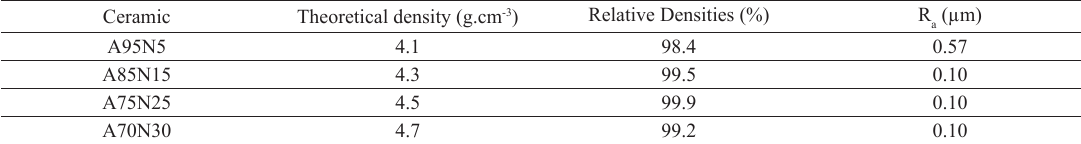
Figure 1. Optical micrographs of polished and etched composite surfaces: a) A95N5, b) A85N15, c) A75N25, d) Table 1. Density and roughness of the ceramic composites